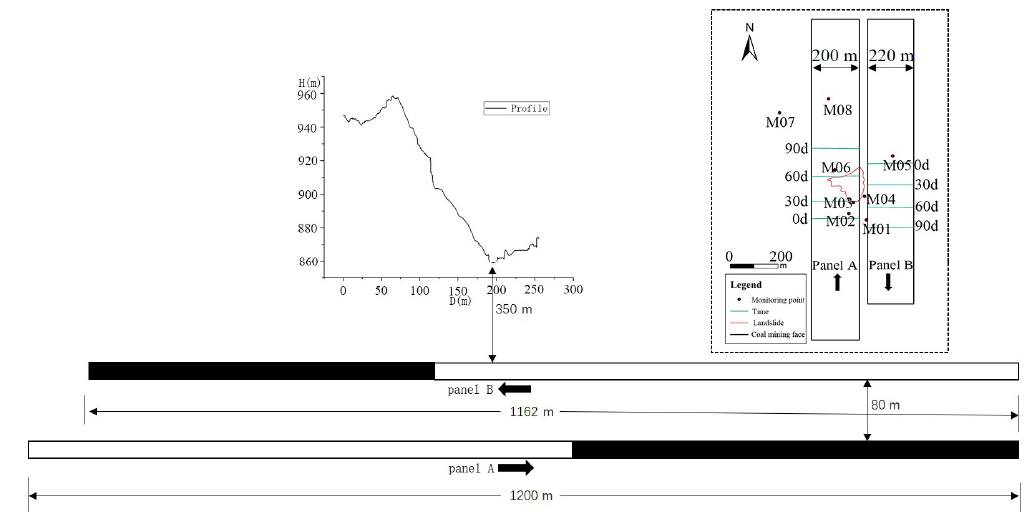
Figure 7. The relationship between the relative position of the slope body and the coal mining activity in both panels.